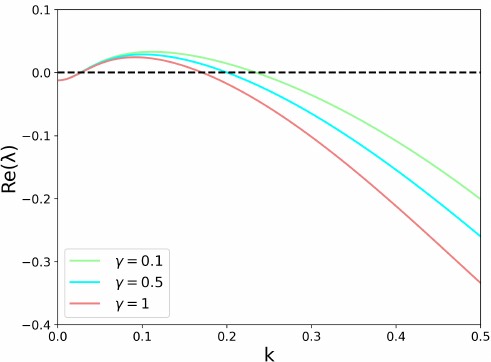
Figure 5. V 2 = 0.02, V 4 = 0.03, R = 0.71, and T = 21. Other parameters can be found in Appendix B.